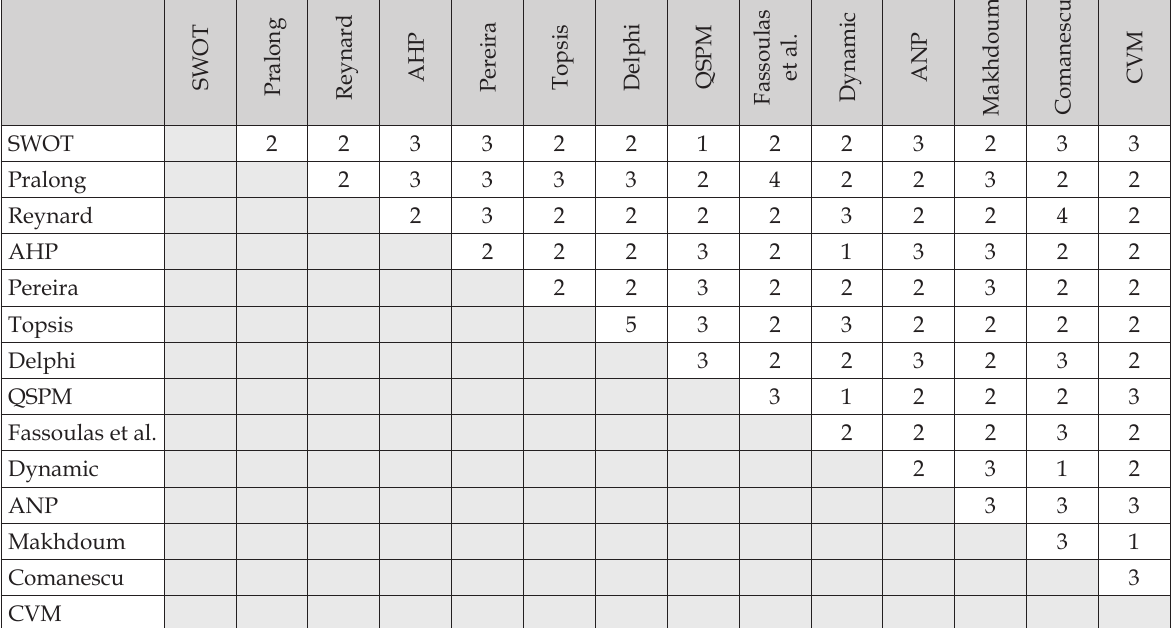
Table 6. The pairwise comparison matrix chart for ‘Order in Structure’ criterion in the expert choice software environment.